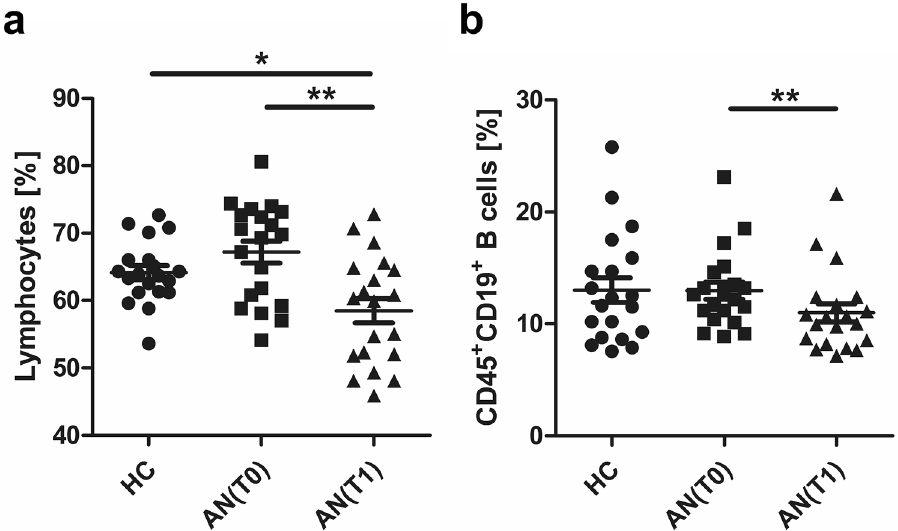
Figure 1. Lymphocytes and B cells in PBMC of healthy controls (HC) and adolescents with anorexia nervosa (AN). Graphs displaying frequencies of ( a ) lymphocytes and ( b ) CD45 + CD19 + B cells in HC (n = 20) and AN at T0 (n = 20) and at T1 (n = 20). P- values vs. HC were calculated by t test for independent samples, T0 vs. T1 by t test for paired samples, * p < 0.05; ** p <